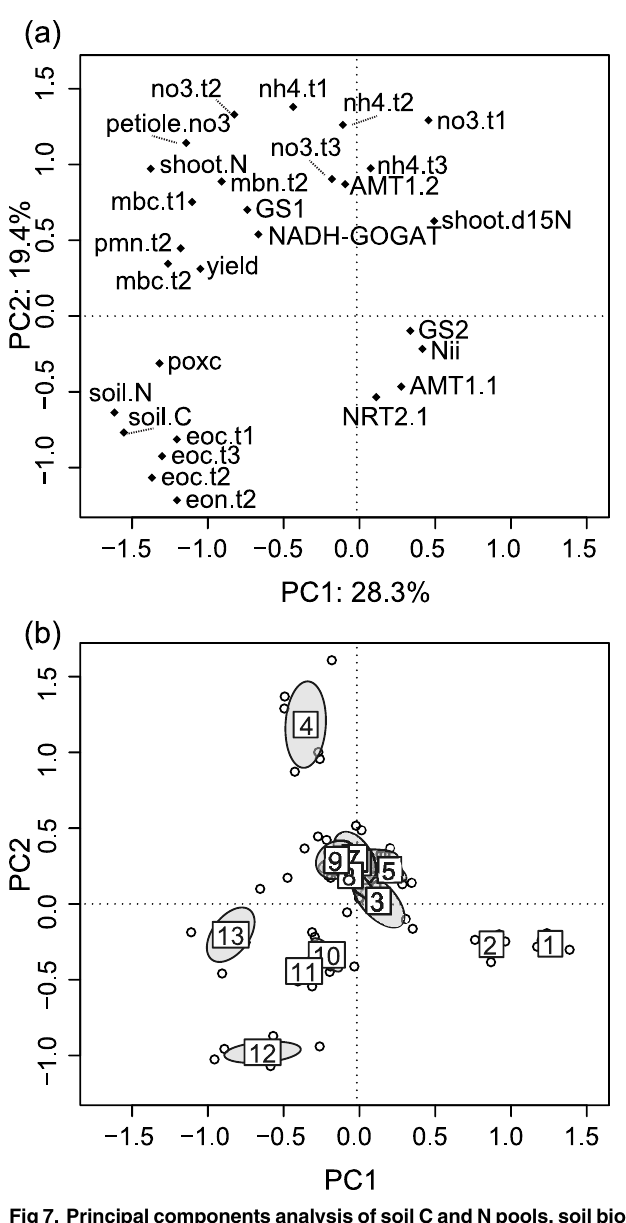
Fig 7. Principal components analysis of soil C and N pools, soil bioassays, tomato yield and N, and expression of key N metabolism genes in roots. Samples are from surface soil (0 – 15 cm) and adjacent plants from 13 organic Roma-type tomato fields in Yolo Co., California, USA. Axes 1 and 2 account for 28.3 and 19.4% of the total variation, respectively. (a) Variable loading plot. Appended suffixes “ t1 ” , “ t2 ” , and “ t3 ” refer to sampling time: pre-transplant, mid-season, and harvest, respectively. (b) Sample scores with 95% confidence ellipses for fields, numbered 1 – 13 (6 samples per field). N metabolism genes include: high- affinitity NH 4+ transporters AMT1.1 and AMT1.2; high-affinity NO 3- transporter NRT2.1; nitrite reductase Nii; cytosolic glutamine synthetase GS1; plastidic/chloroplastic glutamine synthetase GS2; glutamate synthase NADH-GOGAT.